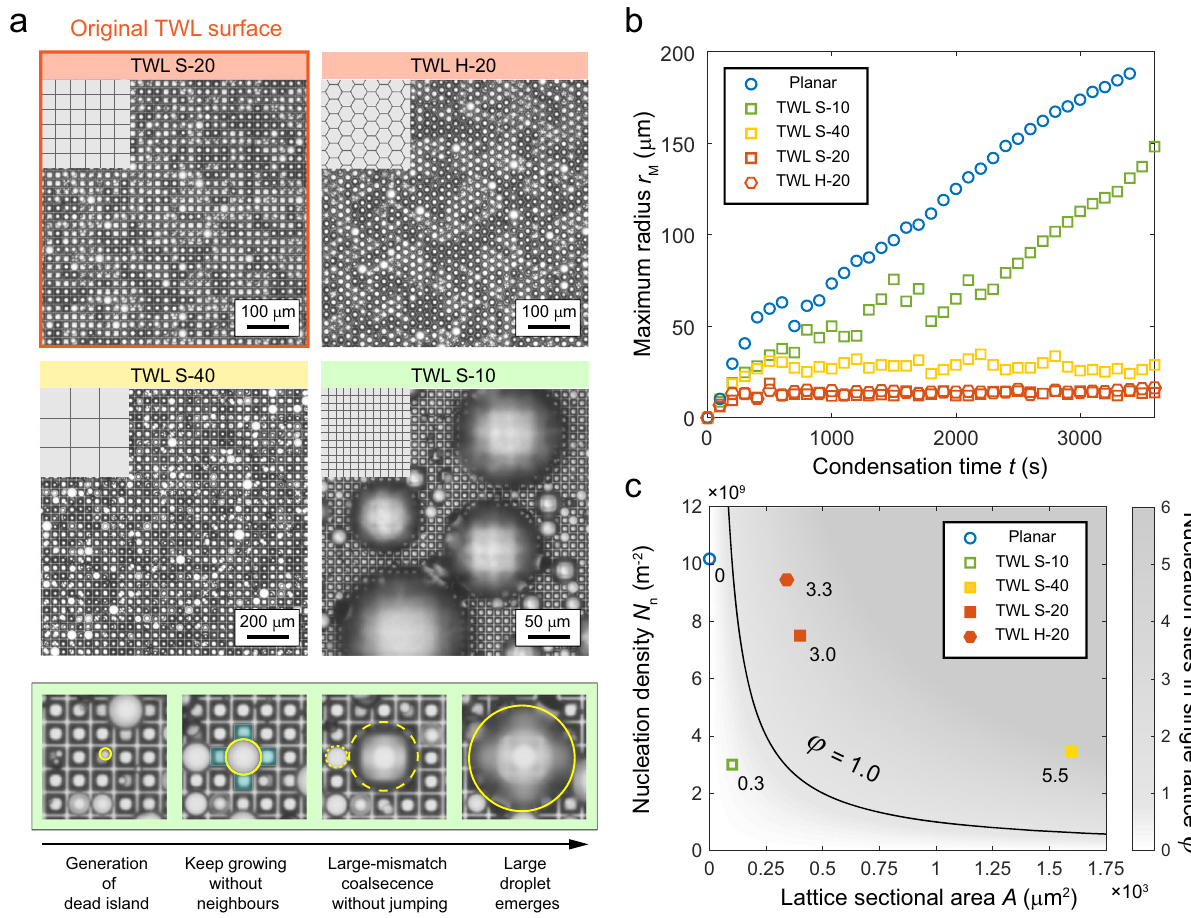
b Variation of maximum radius r M with condensation time t on different surfaces. c Color map showing the relationship between φ , N n , and A . The black curve is the critical line separating functional (solid dots) and unfunctional condensation dro- plet sieves (hollow dots). The numbers accompanying the dots show their values of φ